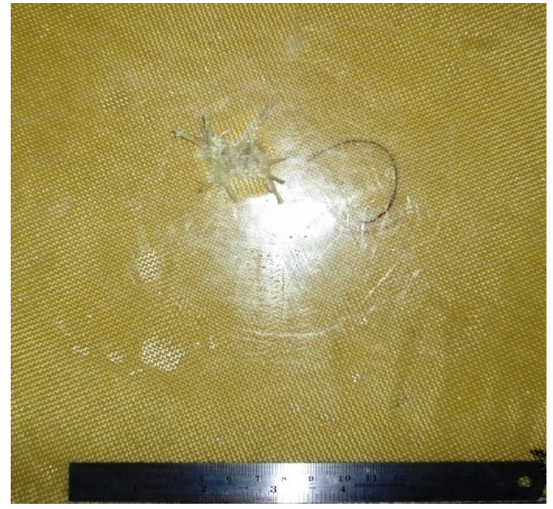
Figure 10. Damage on rear side of 15 layers 0/90